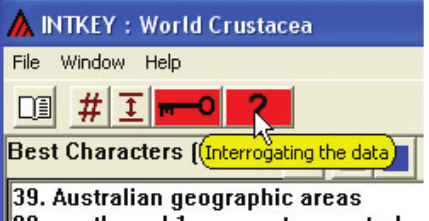
Figure 40. Identifi cation button.